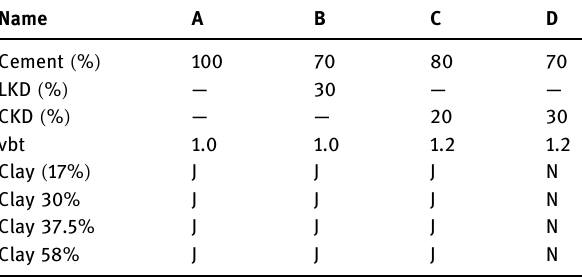
Table 1: Tested binder combinations for the reinforcement of the jet grouting column. J = performed, N = not performed